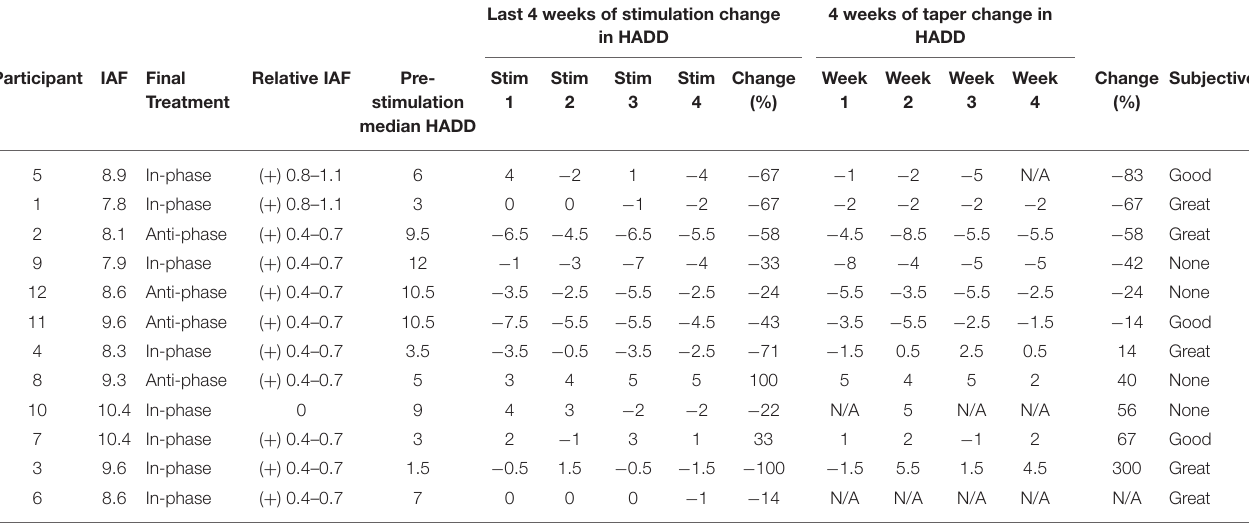
TABLE 3C | Hospital anxiety depression scale-depression subscale (HADD).